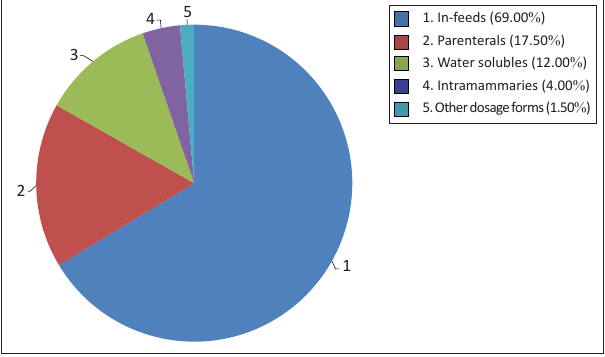
FIGURE 5: Percentages of dosage forms of antimicrobials sold during 2002–2004.